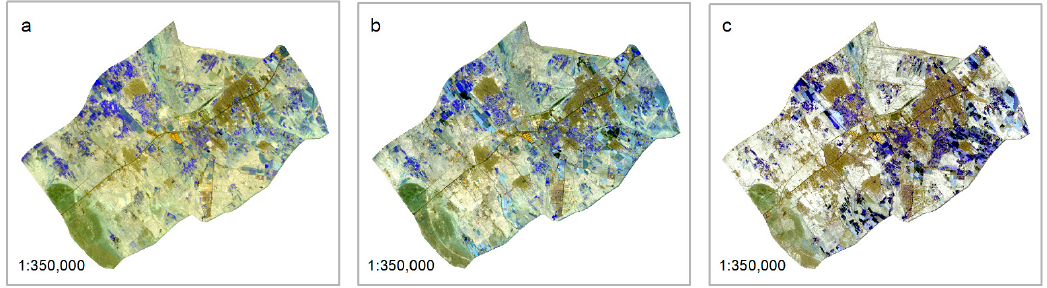
Figure 2. ( a ) SPOT 2, ( b ) SPOT 3, and ( c ) SPOT 4 satellite images.